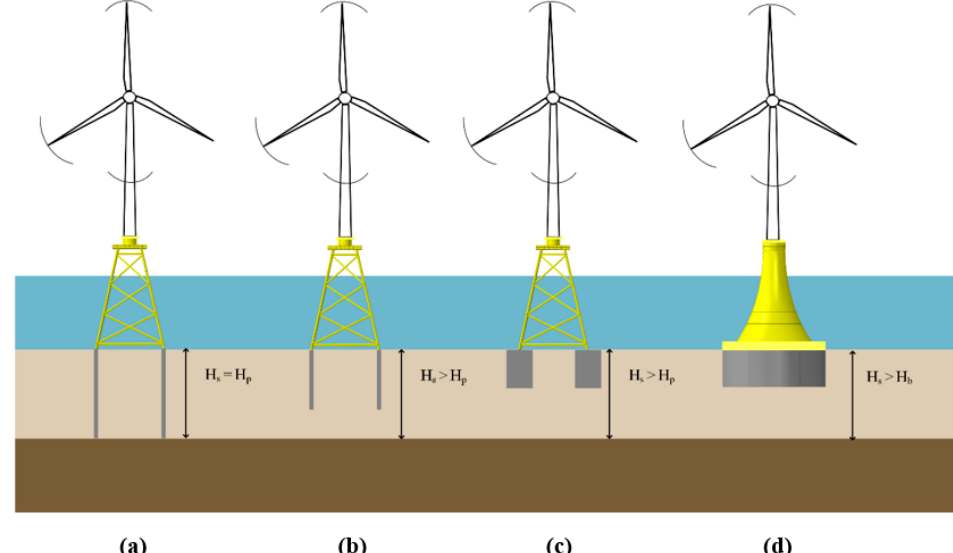
Figure 2. Illustration of four different foundation types: ( a ) End pile; ( b ) floating piles; ( c ) suction caisson; ( d ) wide-shallow bucket foundations (WSBF). Note: H s denotes thickness of soil layer, H p denotes skirt length of pile and suction caisson, H b denotes skirt length of WSBF.